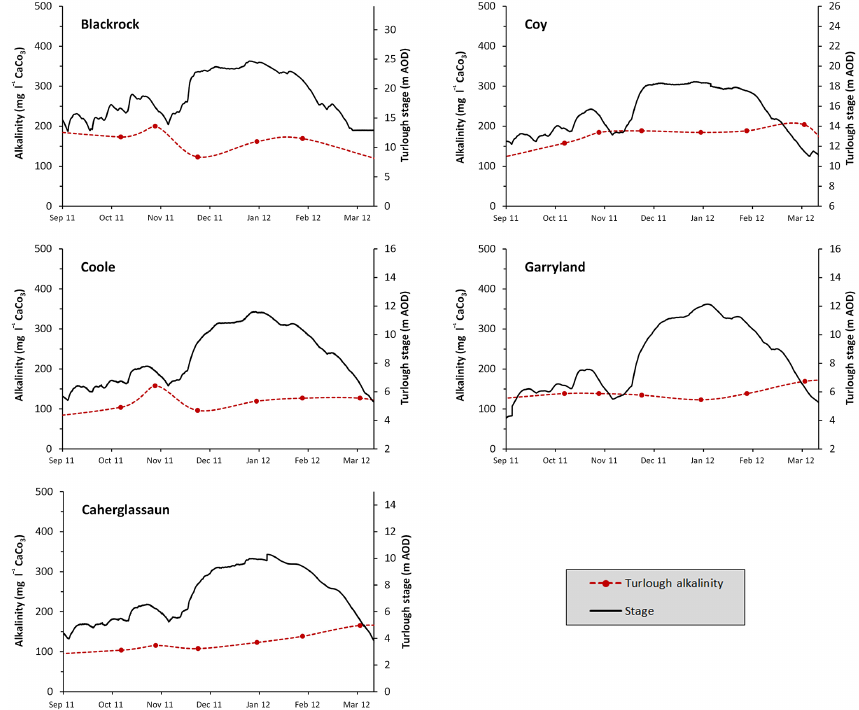
Figure 4. Turlough stage and alkalinity results for Blackrock, Coy, Coole, Garryland and Caherglassaun turloughs over the 2012–2013 flood- ing